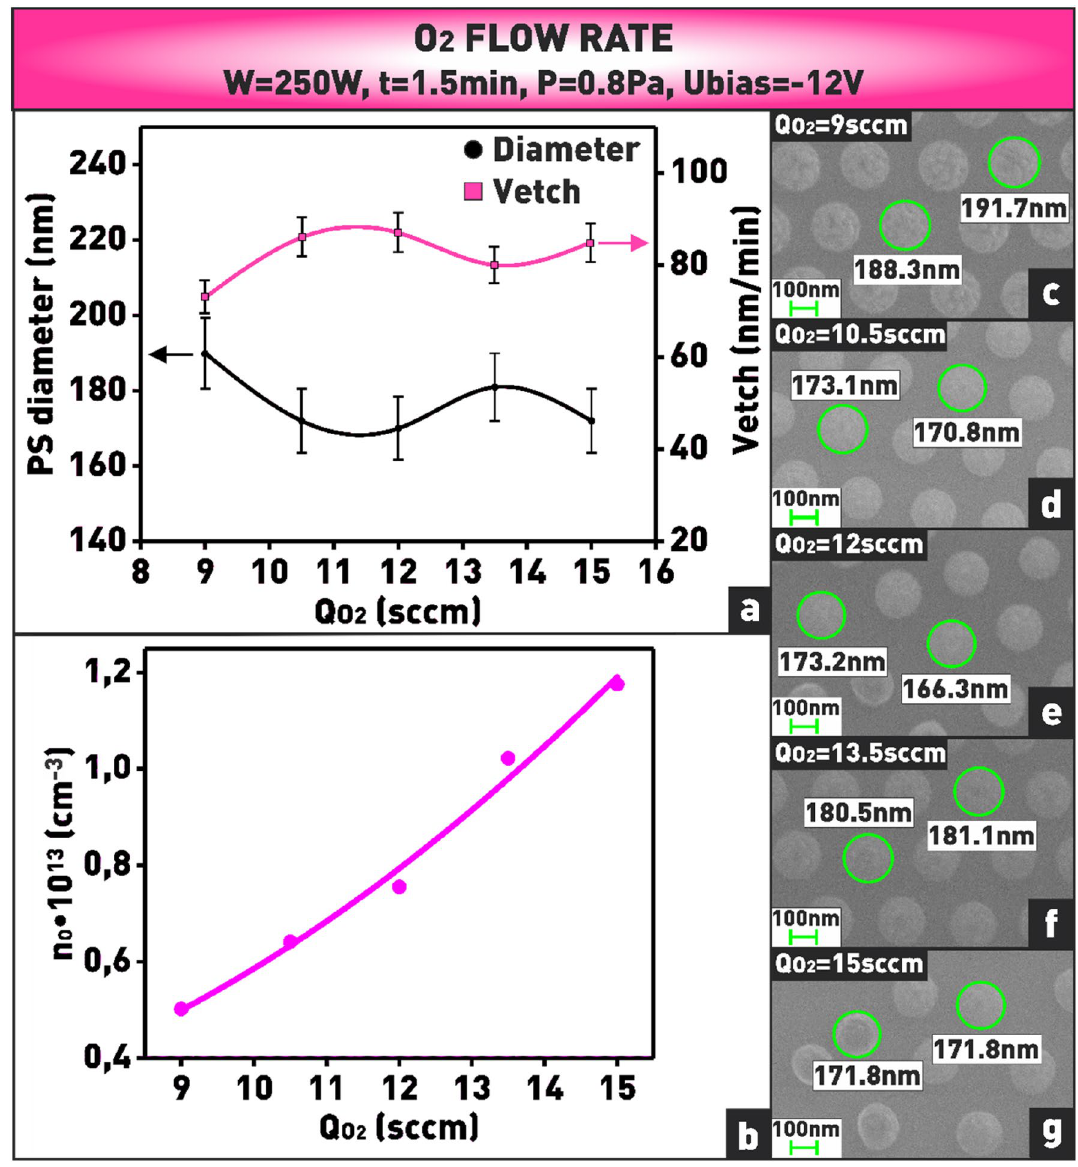
Figure 13. (a) Plot of dependence of nanosphere diameter and etching rate on oxygen flow rate; (b) plot of dependence of oxygen atom concentration on oxygen flow rate; (c–g) microphotographs of nanosphere mask obtained at varying oxygen flow